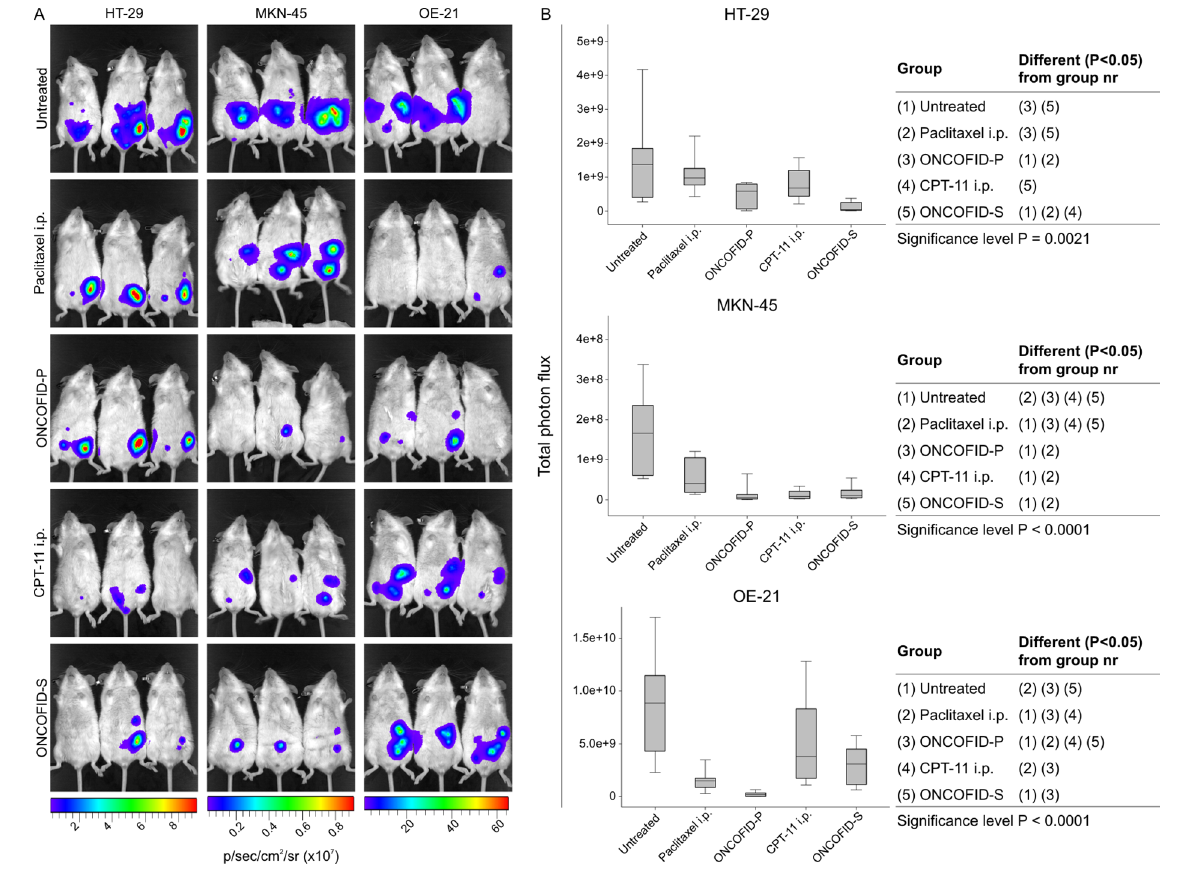
Figure 5. Assessment of invivo tumor growth and response to therapy. A, bioluminescence imaging of pharmacologically treated or untreated mice with peritoneal carcinomatosis induced by luciferase-transduced tumors. Panels show three representative mice per group at one month after tumor injection. B, cumulative results. Each box plot reports mean 6 SD of total photon emission from 6 mice per group at one month from peritoneal carcinomatosis induction. Statistical analysis (Kruskal-Wallis test) is reported in tables at the right of each panel.